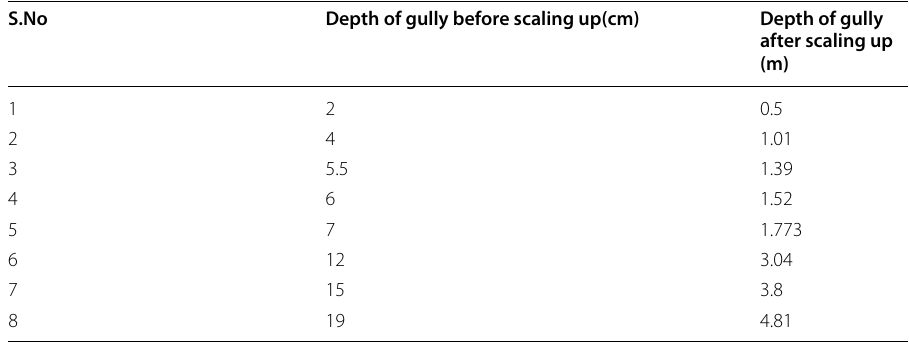
after scaling up (m)